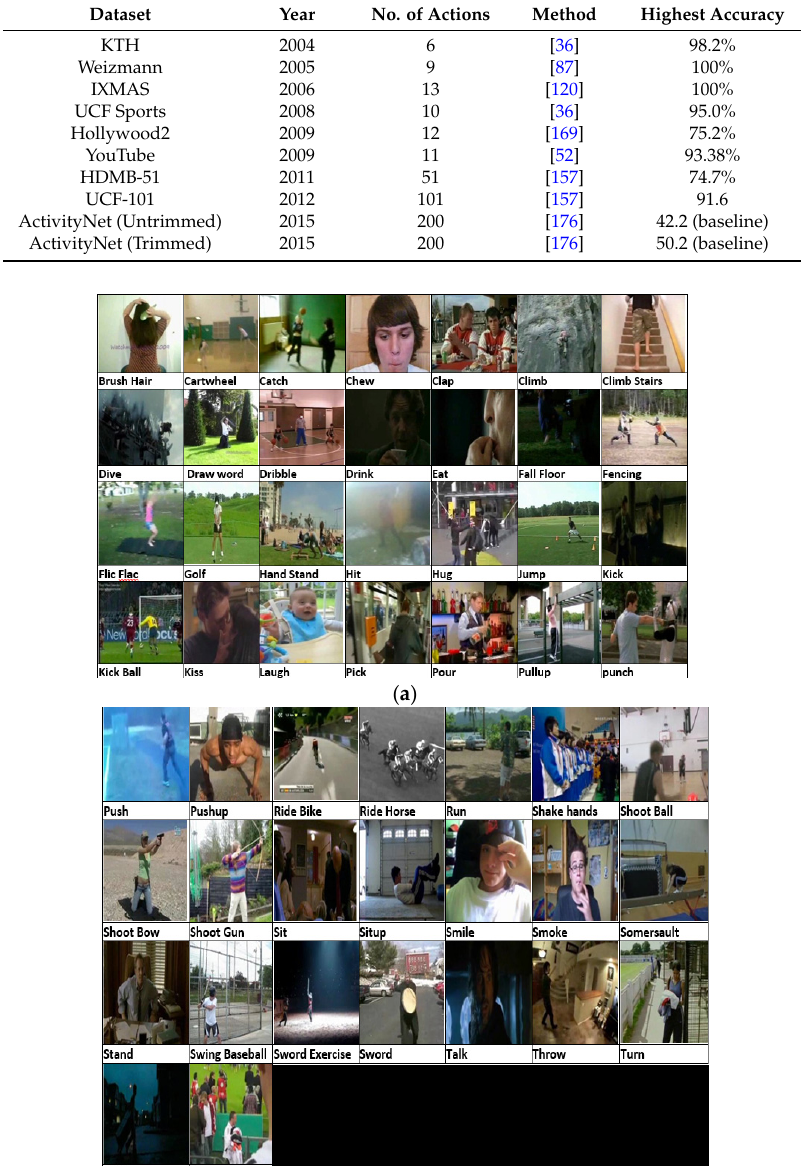
Table 4. Well-known public datasets for human activity recognition.